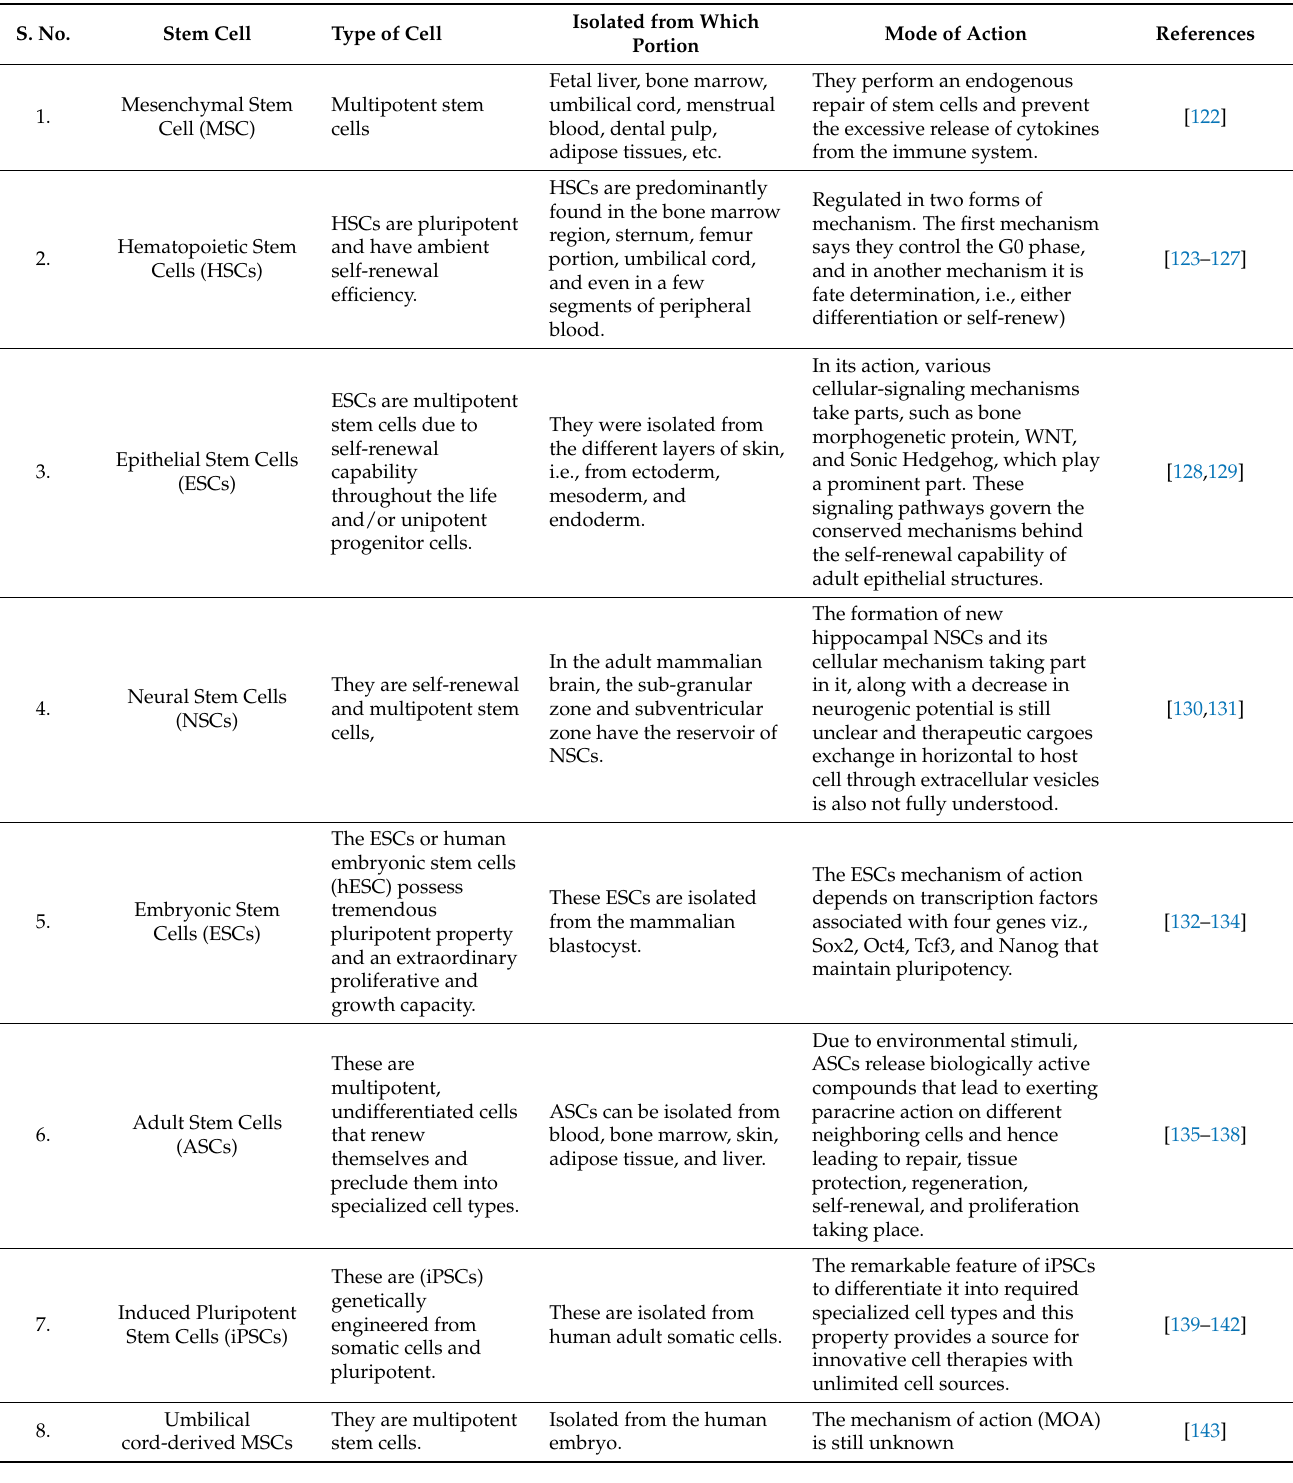
Table 2. Stem cell type, source, and their mechanism of